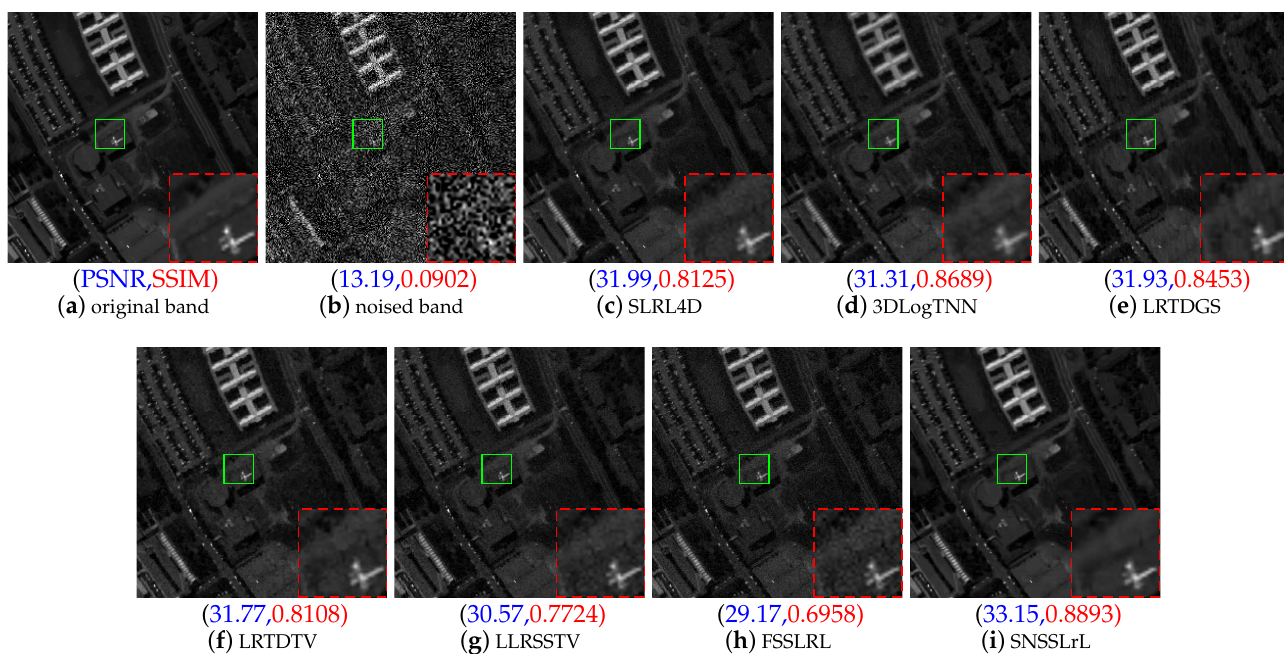
Figure 5. Band image on spectral band 23 of PU dataset under simulated Case 1. ( a ) Original band; ( b ) Noised band;